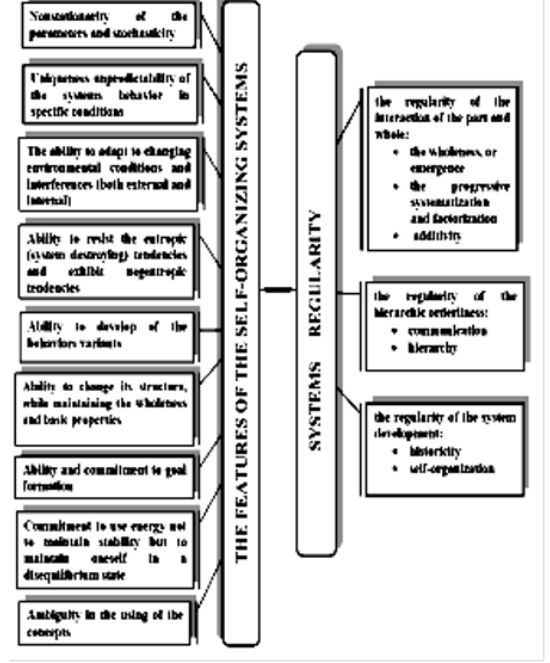
Fig.1. The features and the regularity of the self-organizing